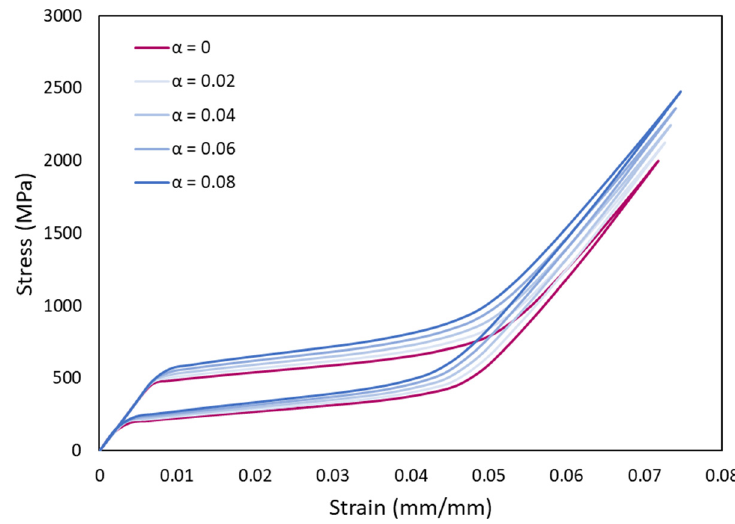
Figure 15. Stress–strain curves showing asymmetry between compression and